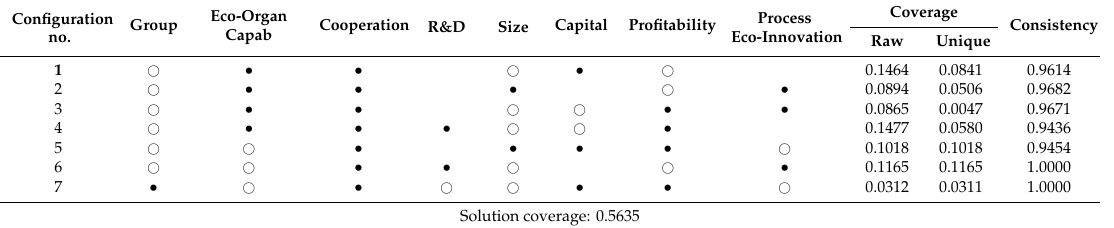
Table 7. Model predicting the development of internal product eco-innovations in agri-food companies. Configuration Group Eco-Organ no.